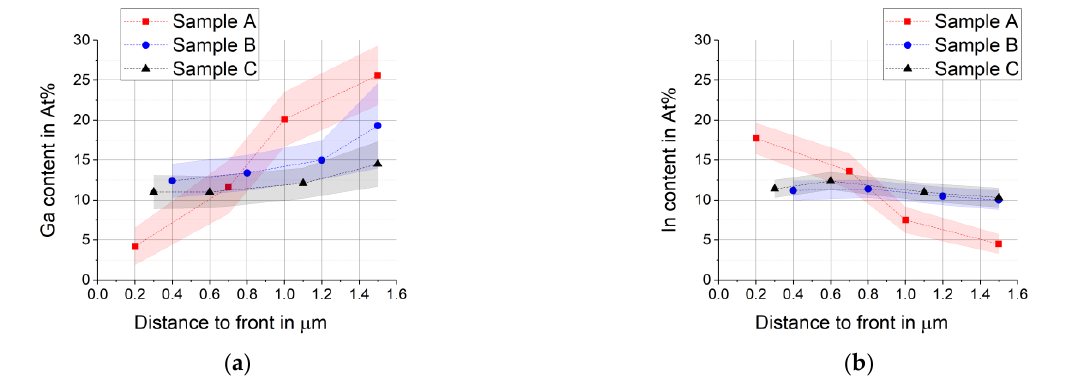
Figure 6. EDX line scans at 20 keV on the cross section parallel to the back contact. Points represent average of the line scan at the distance given, shaded area represents the standard deviation, the connecting lines between individual points serve as guide for the eye: ( a ) Gallium gradient; ( b ) Indium gradient.